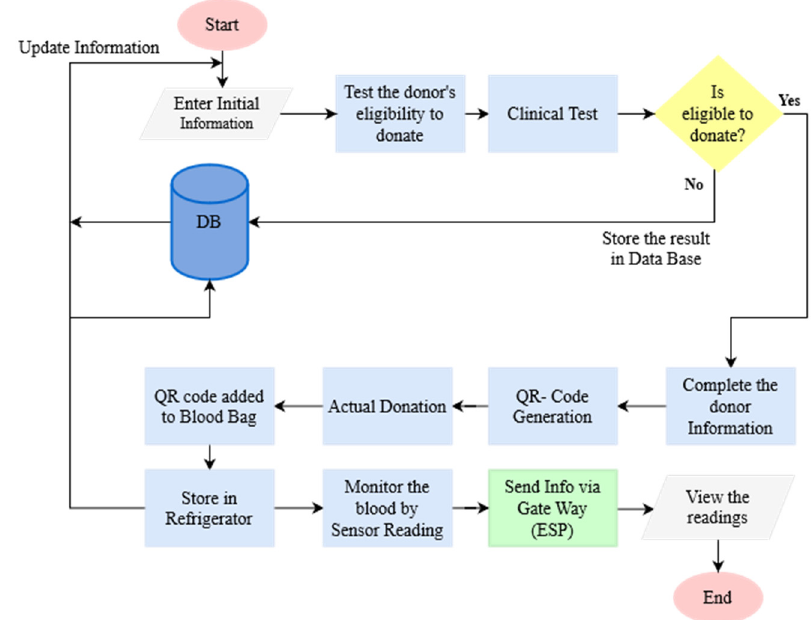
Figure 5. The flowchart of the entire proposed system. Finally, Figure 6 shows the flowchart of the sensor work flow.